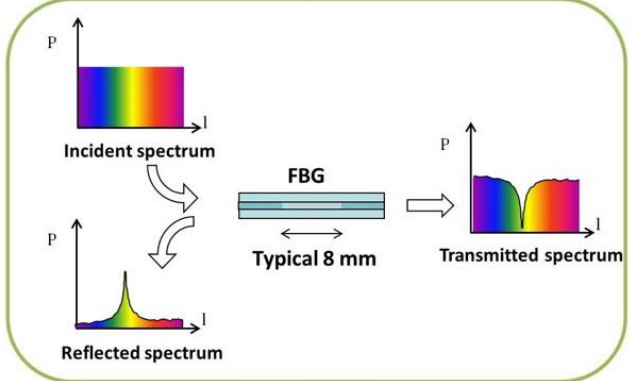
Figure 1. Light reflection diagram in a Fiber Bragg Grating-FBG sensor.